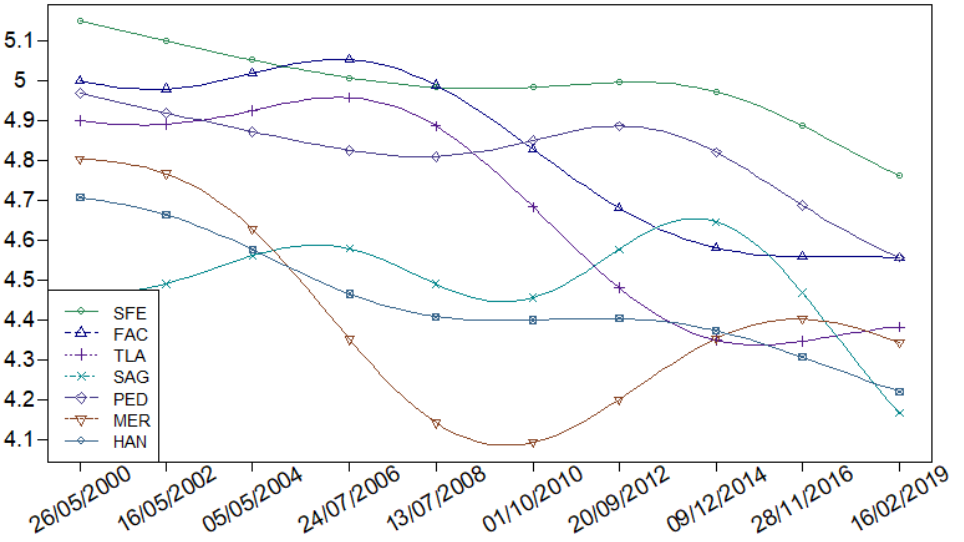
Figure 6. Estimates of the temporal trend for the location GEV parameter of the UVB radiation maxima distribution for monitoring